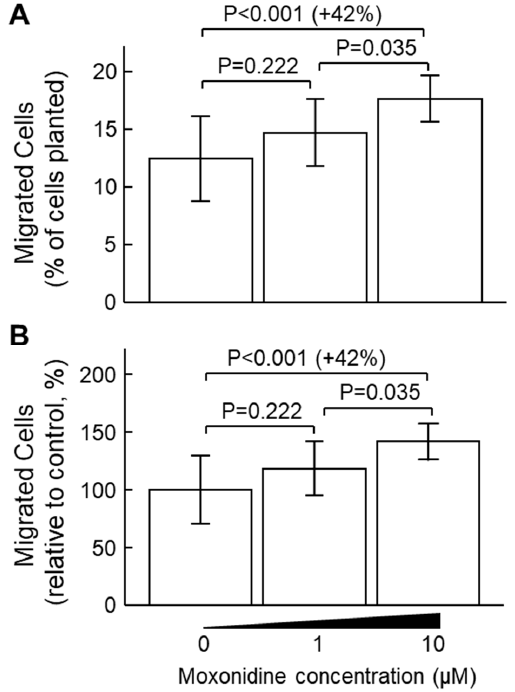
Figure 5. Effect of moxonidine on cellular migration of vascular smooth muscle cells (VSMCs). VSMCs in serum-free DMEM media were placed in the upper chamber of cell migration chambers, with or without moxonidine at the indicated concentrations. The lower chamber contained 150 µL of DMEM medium containing 20% foetal bovine serum. After 48 h incubation, the migrated cells in the lower chamber were stained and the fluorescence (an indicator of cell numbers) was measured (excitation/emission = 530/590 nm). ( A ) Migratory cells were represented as a percentage of the total number of cells planted in the upper chamber. ( B ) Migratory cell numbers relative to the untreated controls (0 µM moxonidine). The difference among the group was analysed using Kruskal–Wallis one-way ANOVA followed by Bonferroni’s post hoc tests. Data represent mean ± SD; N = 11–12 per group.